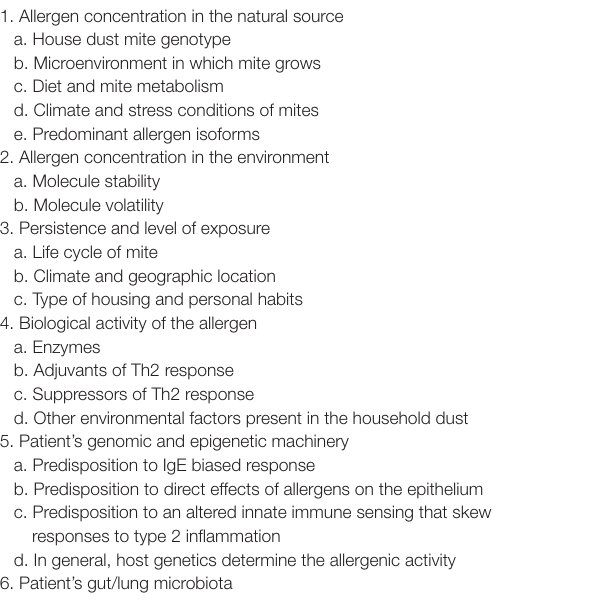
TABLE 1 | Factors influencing the HDM induction of a Th2